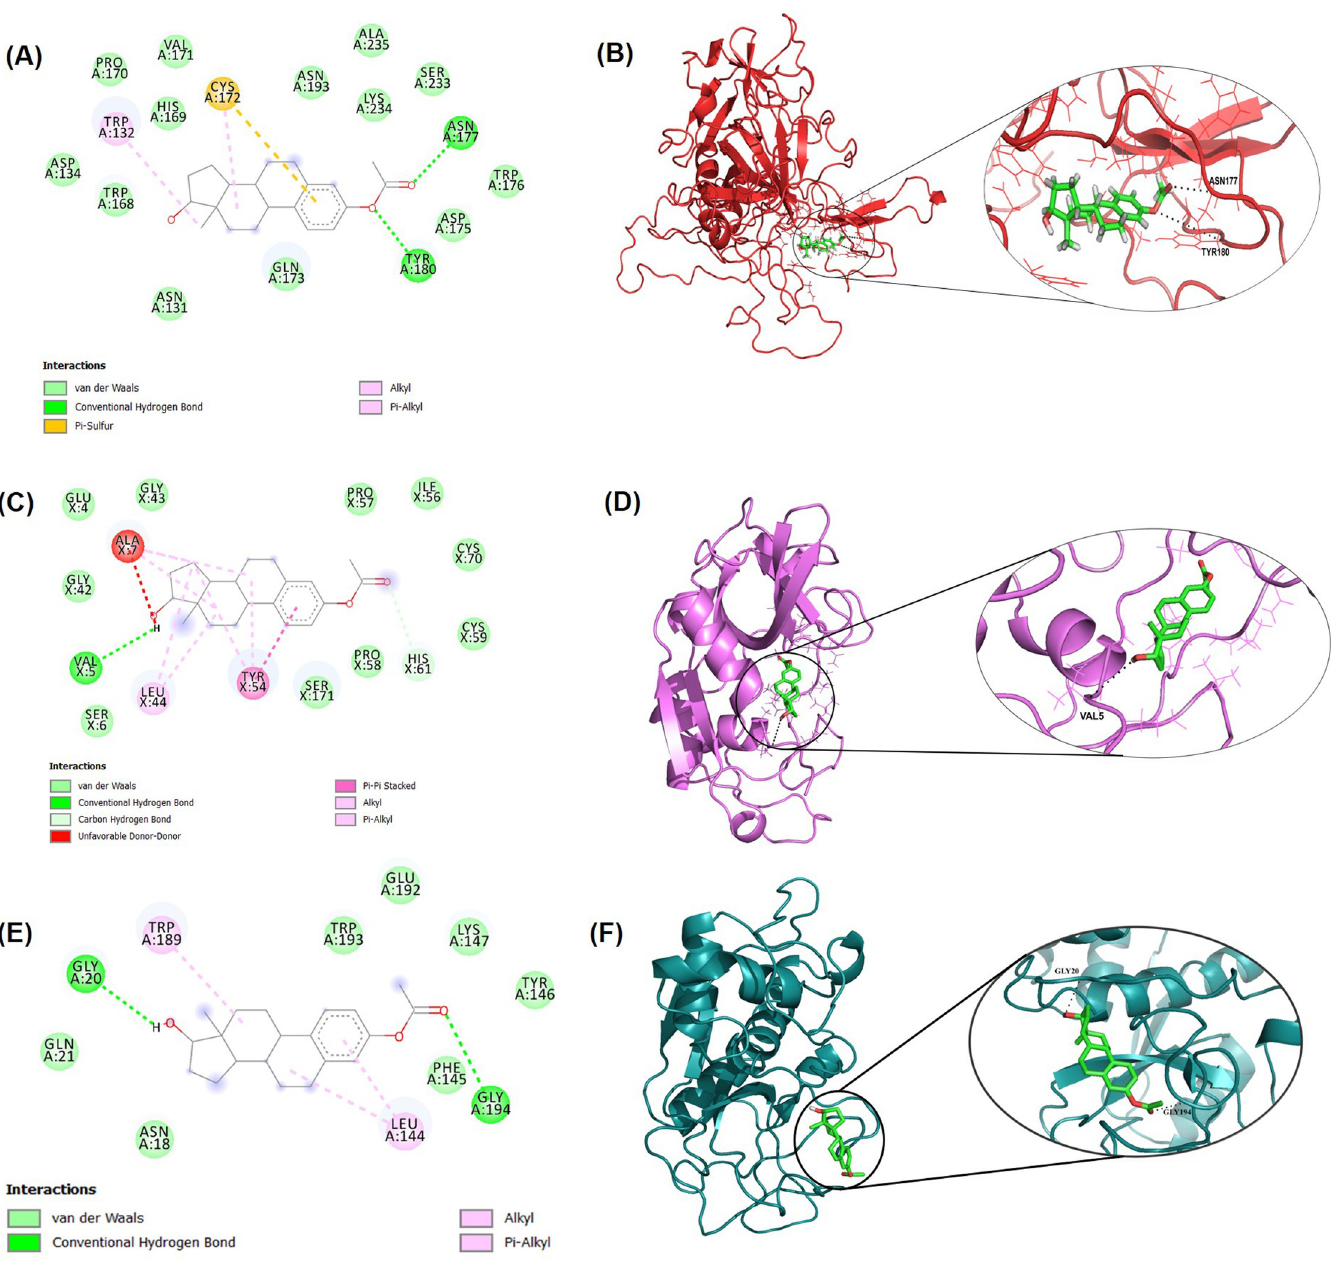
Fig 5. Molecular docking study of estradiol to TMPRSS2, CTSB, and CTSL. (A) Two-dimensional (2D) diagrams of TMPRSS2-estradiol interactions using Ligplot+. The figure provides the information about the interactions, the protein residues and interactions are colored accordingly. (B) The best docking pose in the three- dimensional (3D) structure of the protein. The black dotted line denotes the intermolecular hydrogen bond interactions. Similarly, (C) 2D diagrams of CTSB-estradiol interactions and (D) binding poses in the 3-D structure are shown. (E) and (F) represents 2-D interactions for CTSL-estradiol and 3-D binding poses, respectively. https://doi.org/10.1371/journal.pone.0256141.g005 Retinoic acid binds with CTSB, CTSL, and TMPRSS2 with the binding affinity of -7.9 kcal/ mol, -6.0 kcal/mol, and -6.4 kcal/mol, respectively. Retinoic acid form one H-bond to VAL39 with TMPRSS2 along with thirteen Van der Waal bonds, one carbon-hydrogen bond, and one alkyl and pi-sigma bond each ( Fig 6A and 6B ). Similarly, retinoic acid form two H-bonds at position TRP189 and ASN18 with CTSL along with nine Van der Waal bonds and one alkyl